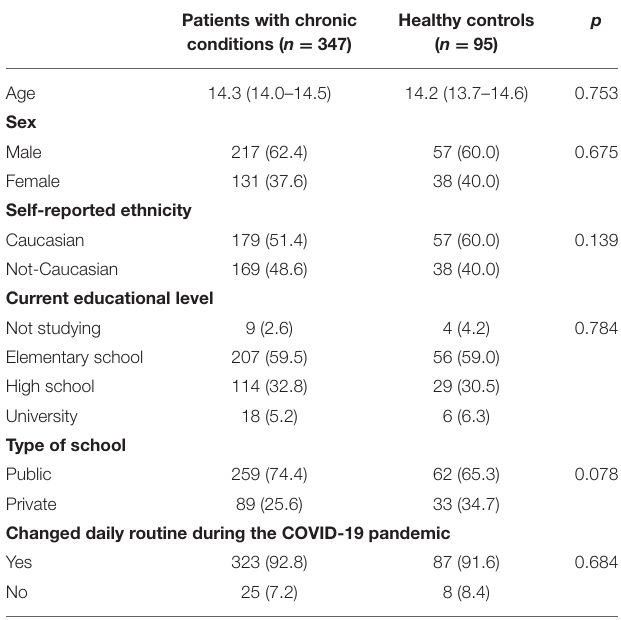
TABLE 1 | General characteristics of